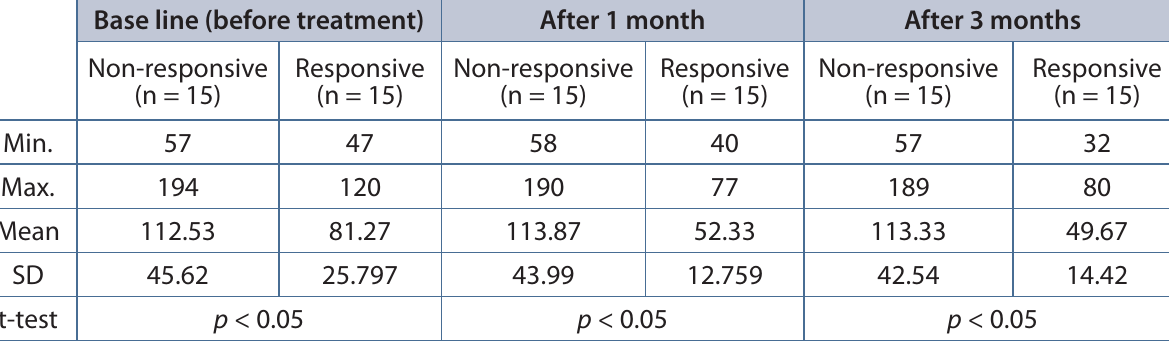
Table 2. Comparison between serum s-ICAM-1 levels (ng/mL) in responsive and non-responsive CHC patients